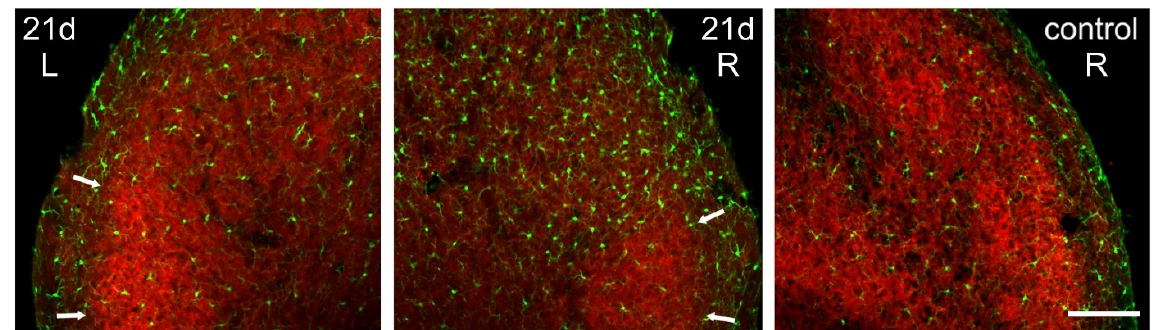
Figure 7. Spatial correlation of microglial reaction to CCI-IoN with GlyT2 expression. The marked ipsilateral microgliosis at 5dpo (not shown) and 21dpo ( right side , middle panel ) was practically restricted to the zones of Sp5C exhibiting low expression of GlyT2, sparing the GlyT2-intense ‘patches’ in lamina III (arrows). Scale bar = 300 µm.